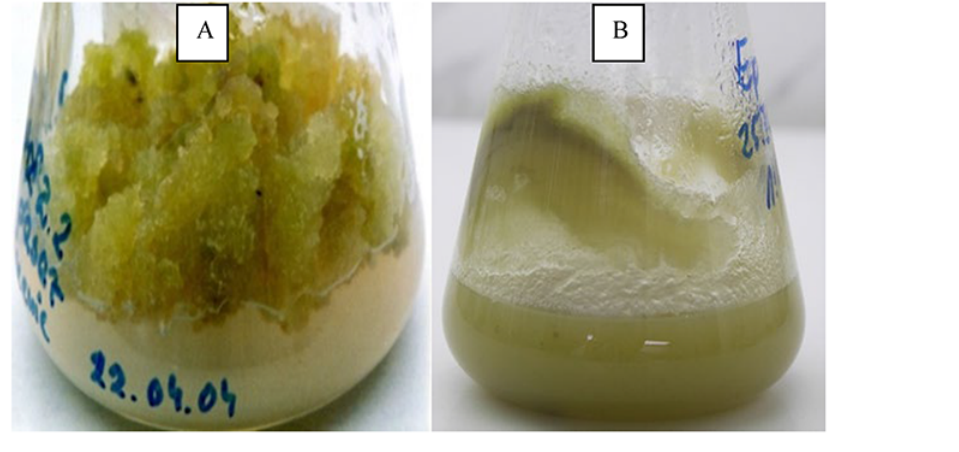
Figure 6 ( A ) Callus and ( B ) cell suspension culture of Eryngium planum